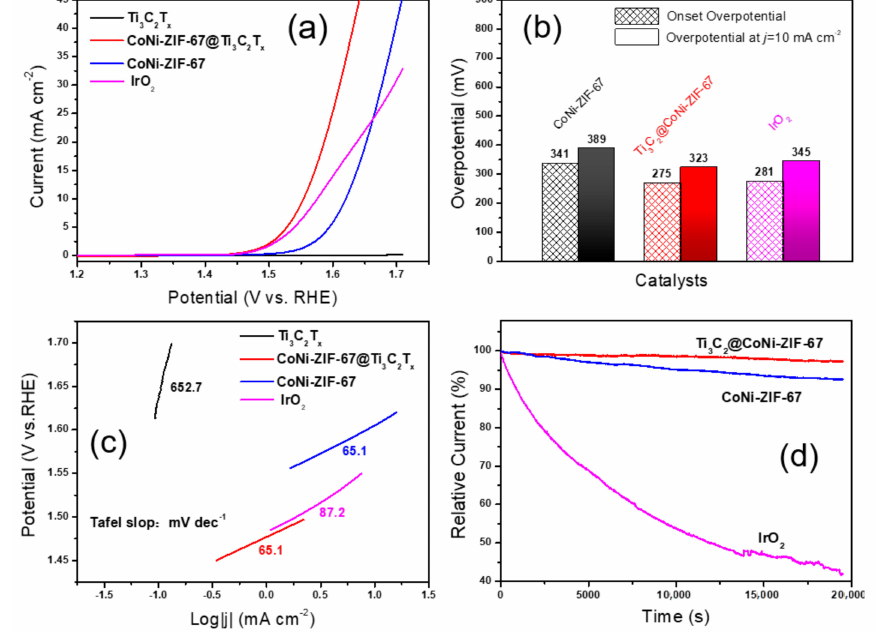
Figure 5. ( a ) Linear sweep voltammetry (LSV) curves of the catalyst Ti 3 C 2 T x , CoNi-ZIF-67@Ti 3 C 2 T x , pure CoNi-ZIF-67 and IrO 2 at 50 mV · s − 1 ; ( b ) A comparison of the catalysts in the onset potential and overpotential at a current density of 10 mA · cm − 2 ; ( c ) Tafel plots of the di ff erent catalysts; and ( d ) Chronoamperometry curves at 1.46 V vs. RHE over a 20,000 s continuous